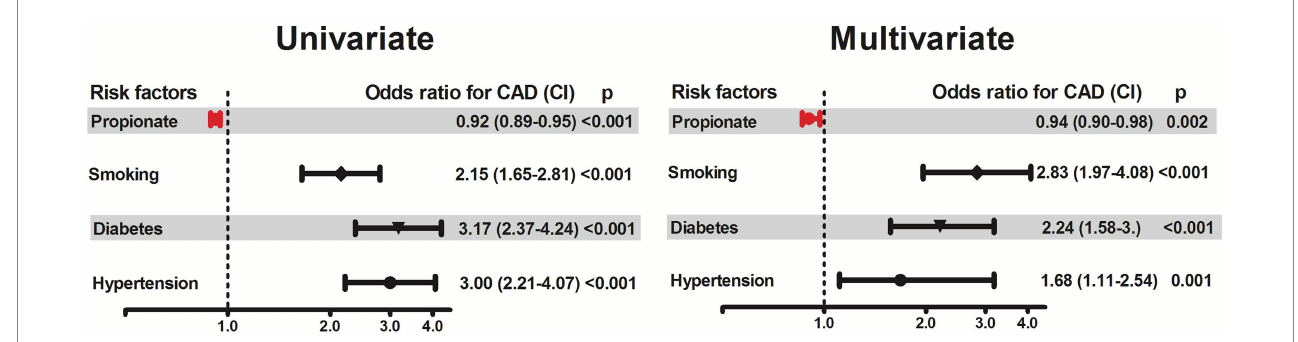
FIGURE 1 Association of propionate concentrations with the presence of coronary artery disease (CAD). The association of propionate with CAD was assessed by logistic regression using univariate and multivariate models adjusted for selected cardiovascular risk factors (hypertension, diabetes, smoking), age, gender, body-mass index and intake of statins. Odds ratios and 95% confidence intervals are presented. Odds ratios for continuous variables are per 1-SD